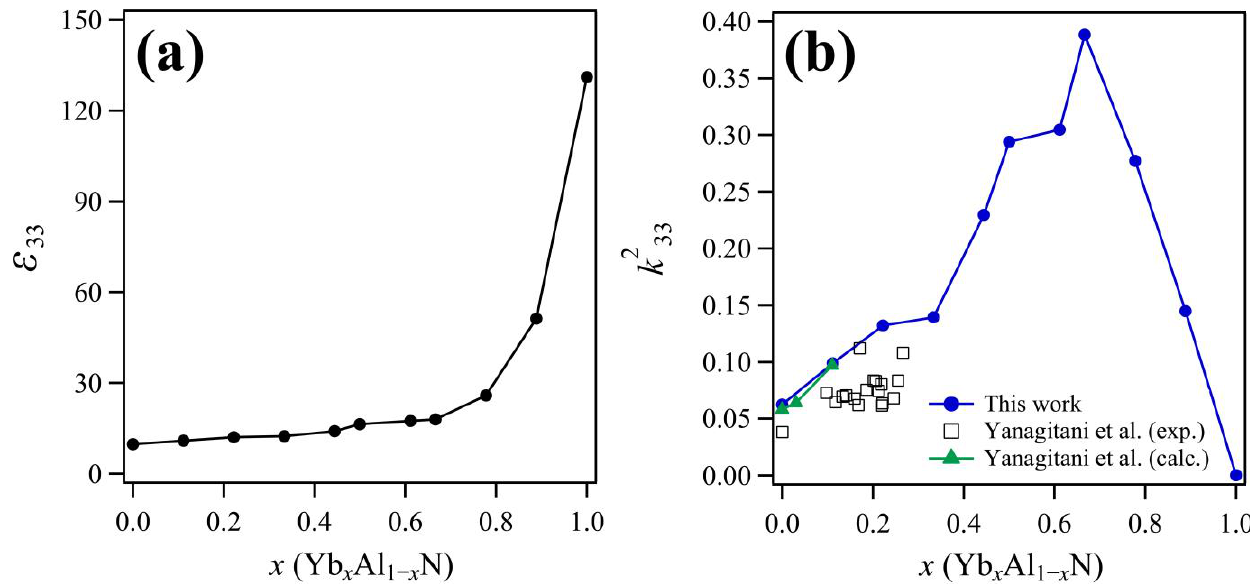
Figure 6. ( a ) Dielectric constant, 𝜀 33 , of Yb x Al 1−x N as a function of Yb content; and ( b ) electromechanical coupling coefficient, 𝑘 332 , of Yb x Al 1−x N as a function of Yb content. The blue trace represents the calculated results from this work, and the black squares and green line represent the experimental and calculated results, respectively, as reported by Yanagitani et al. [15].